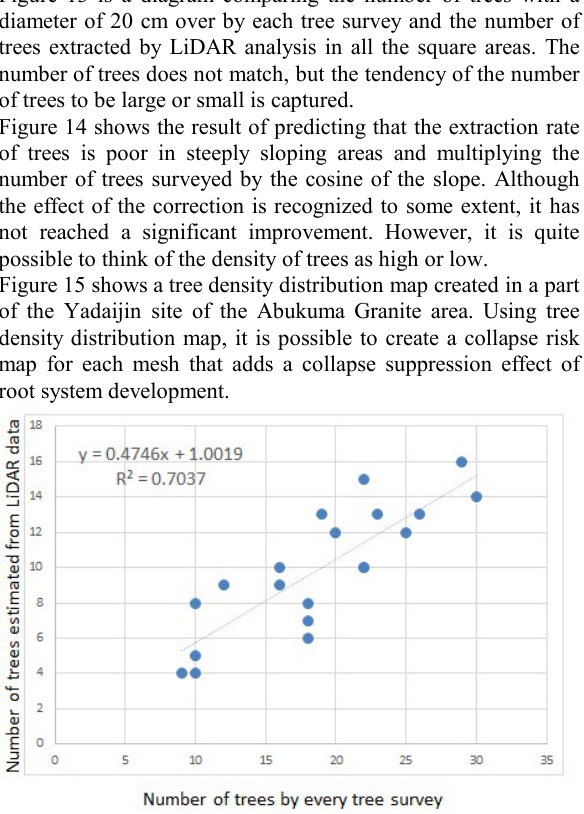
Figure 13 . Relationship between LiDAR data and every tree